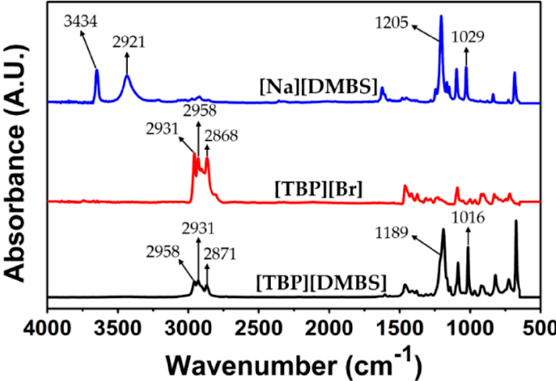
Figure 3. Fourier transform infrared (FT − IR) spectra of [Na][DMBS], [TBP][Br], and [TBP][DMBS] at room temperature.